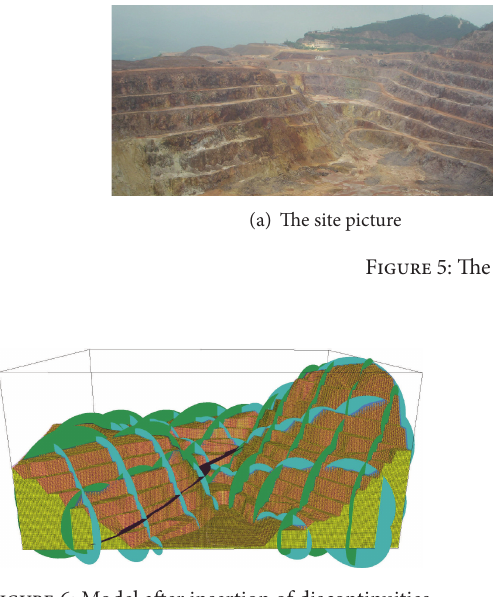
Figure 6: Model after insertion of discontinuities.